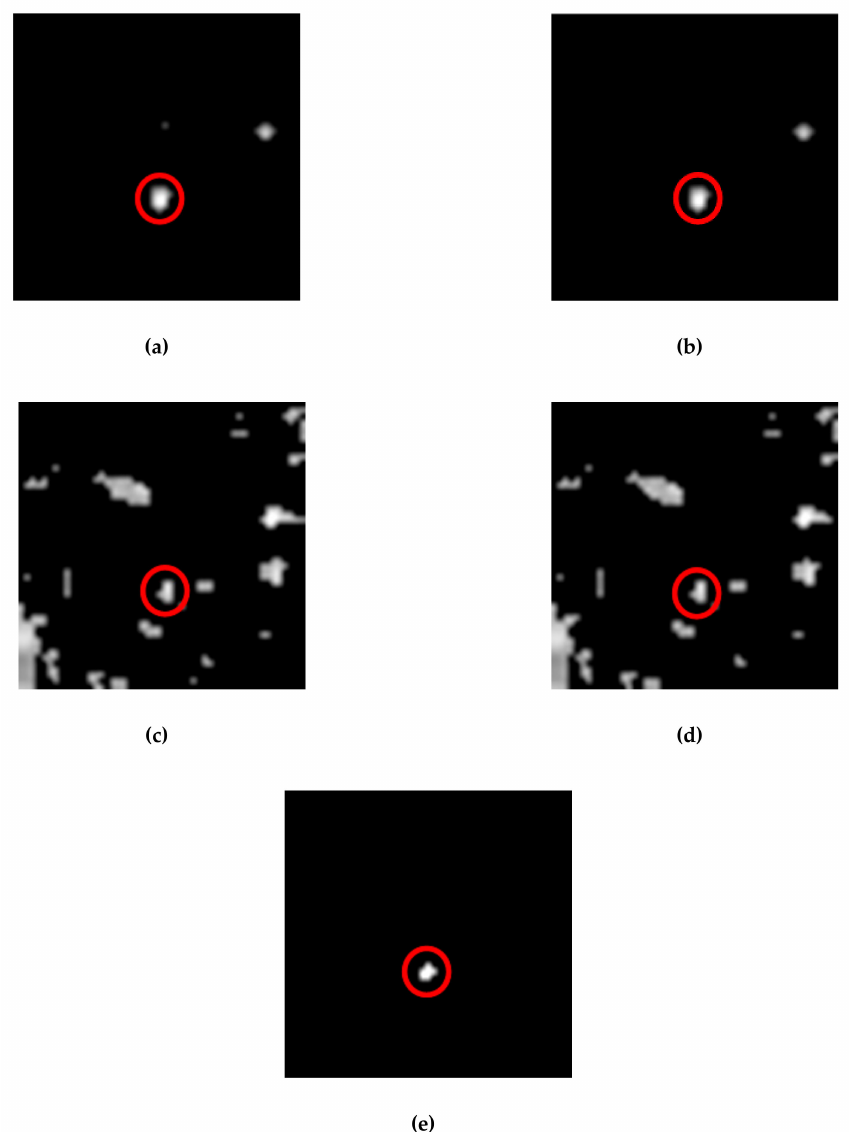
Figure 12. The obtained photovoltaic panel abundance fraction and classification maps for the real sub-image 3: ( a ) Grd-Part-NMF, ( b ) Multi-Part-NMF, ( c ) Grd-NMF, ( d ) Multi-NMF and ( e ) one-class-classification-based. Red circles surround photovoltaic panels.